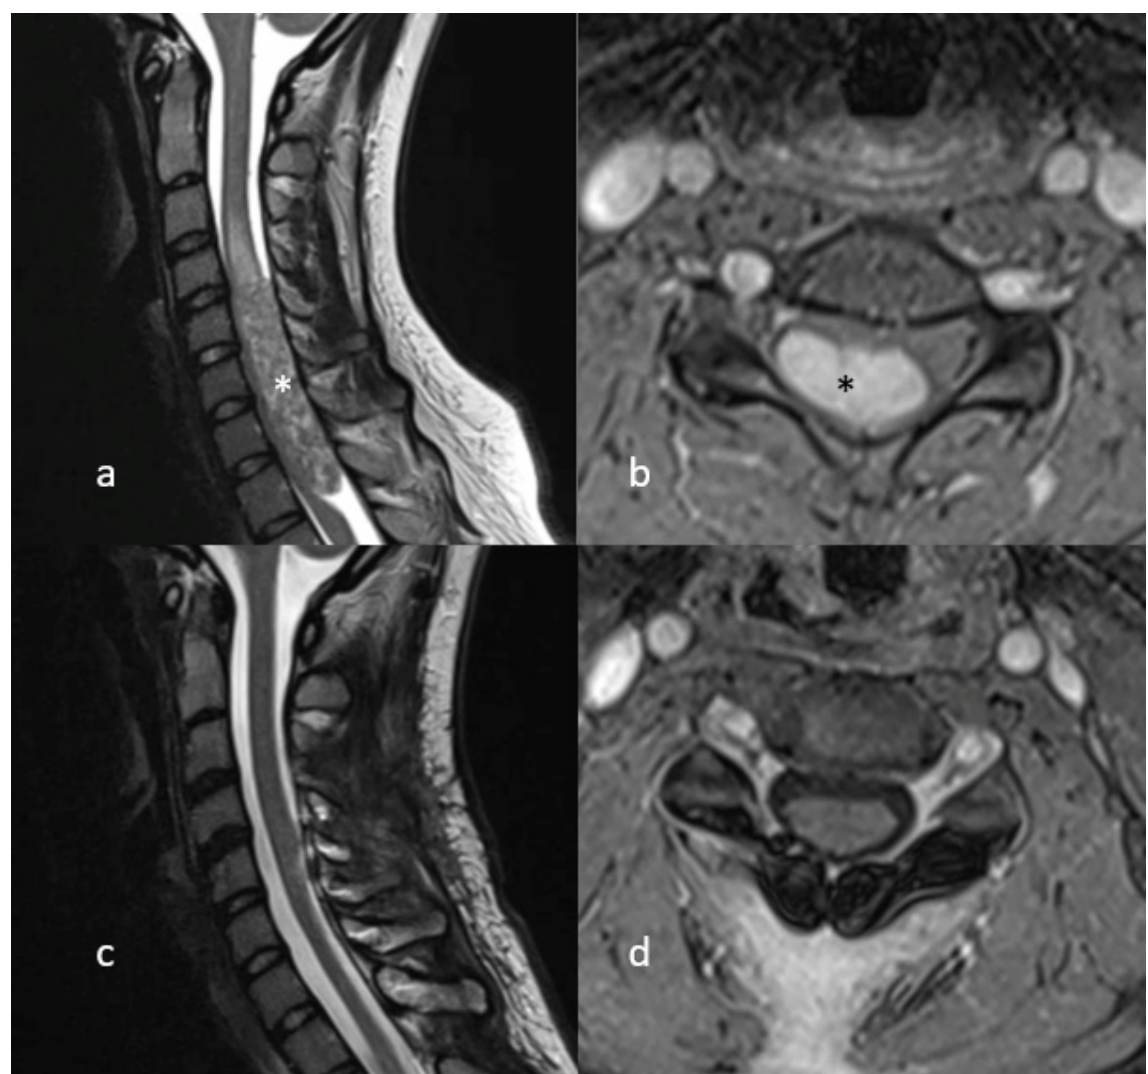
Figure 2. MR Imaging (T2-weighted on the left, T1 with gadolinium on the right) showing a large intradural, contrast-enhancing lesion (marked with asterisk) compressing the cervical spinal cord ( a , b ). Postoperative MR Imaging showing no signs of tumour recurrence ( c , d ).